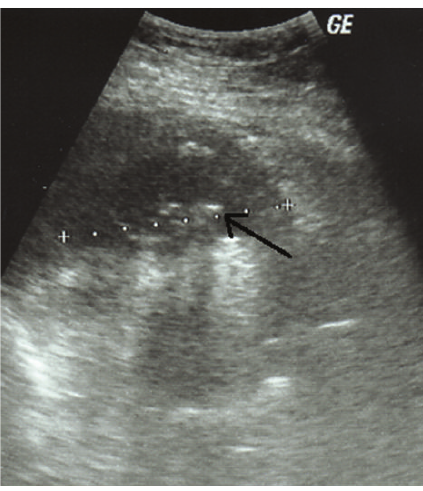
Figure 1: Ultrasound examination showing the presence of a retroperitoneal abscess with hyperechoic foci (spilled gallstones) (arrow).